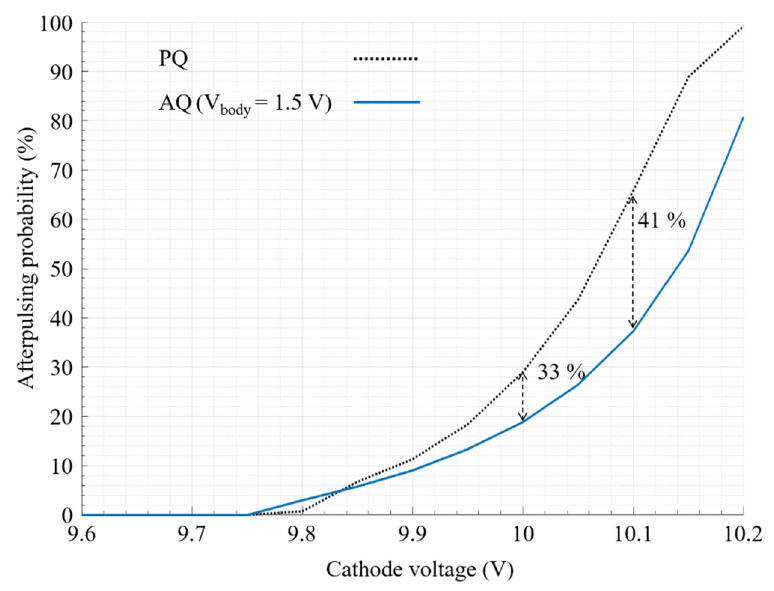
Figure 13. Afterpulsing probability versus excess bias voltage in the PQ and the AQ with 1.5 V of body voltage. The hold of time is 20 ns.